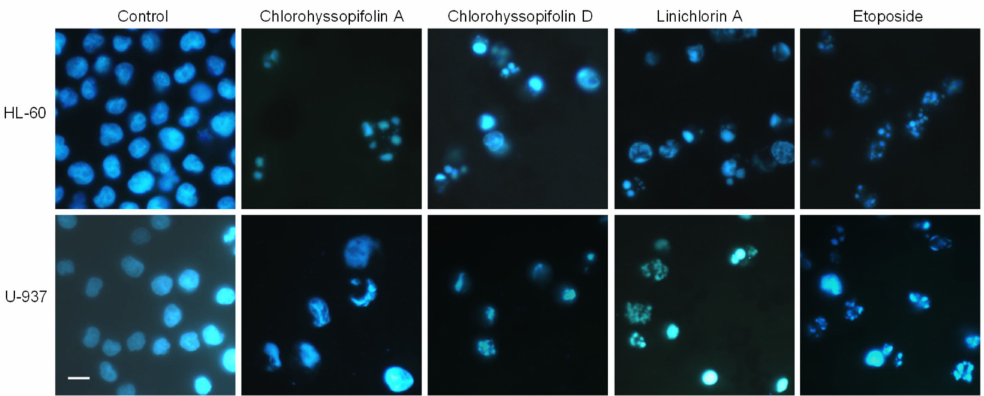
Figure 3. Cells were treated with the indicated guaianolides at a concentration of 10 µ M for 24 h, stained with Hoechst 33,258 and visualized under a fluorescence microscope. Etoposide (3 µ M) was included as a positive control. Original magnification 40 × . Bar represents 10 µ